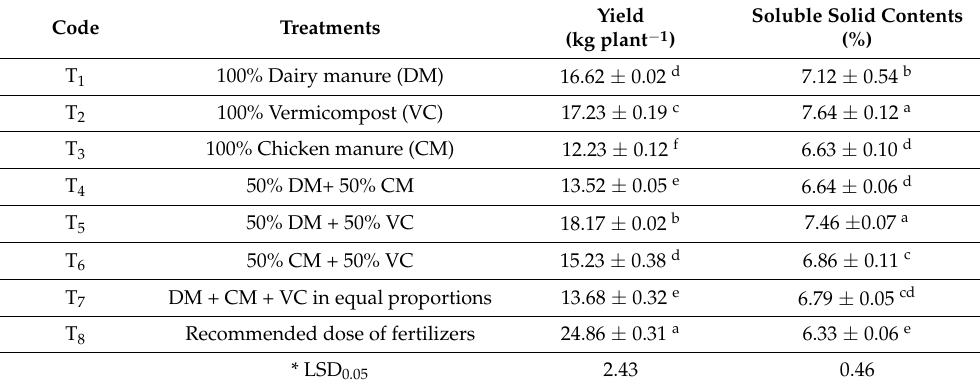
Table 2. Response of nutrient supplementation through organic manures on the yield and soluble solids content of Actinidia deliciosa cv